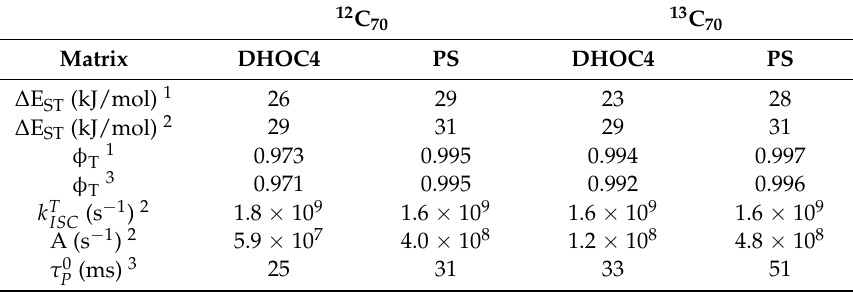
Table 3. Photophysical parameters of 12 C 70 and 13 C 70 in DHOC4 and